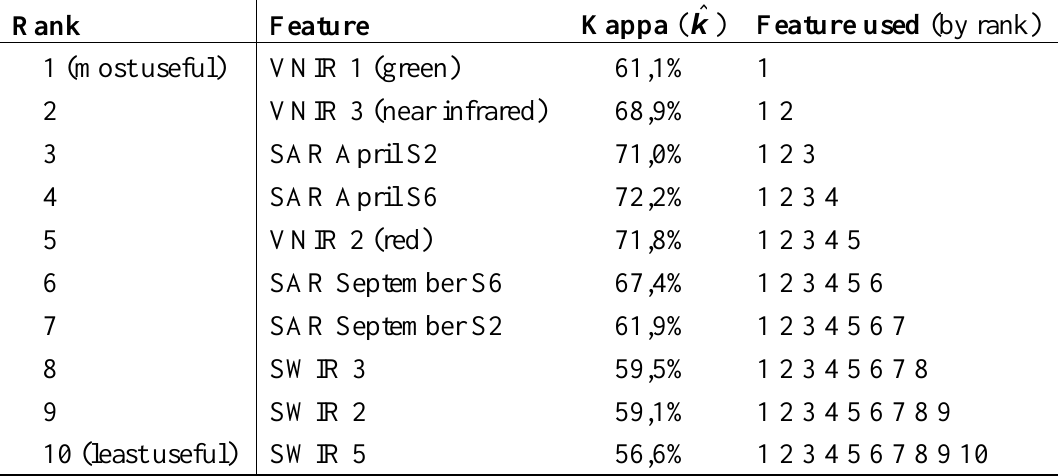
Table 6. Feature ranking results obtained from the “knock-out”